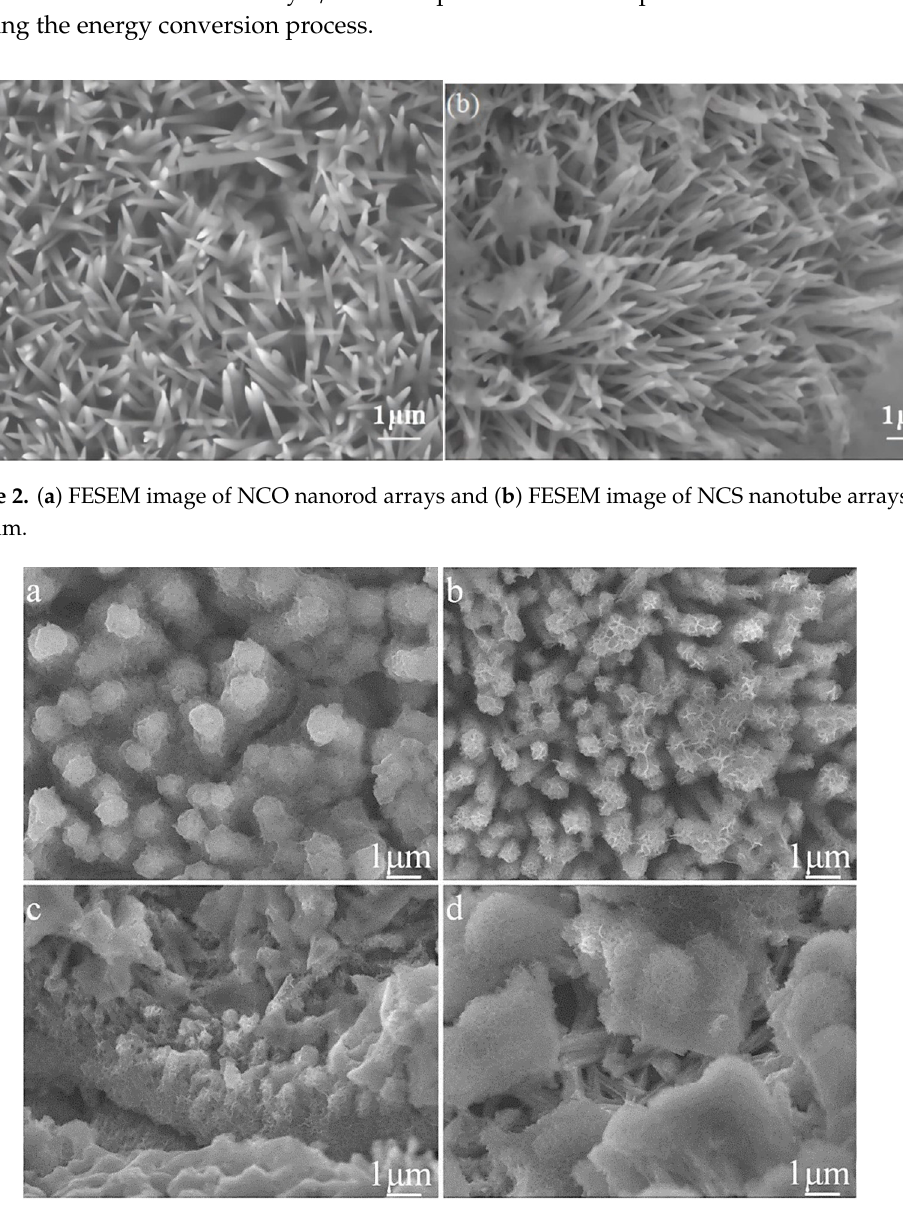
. Figure 4. XRD patterns of the NCS nanotube arrays and NCS@NCOH core-shell nanotube arrays on Ni foam.